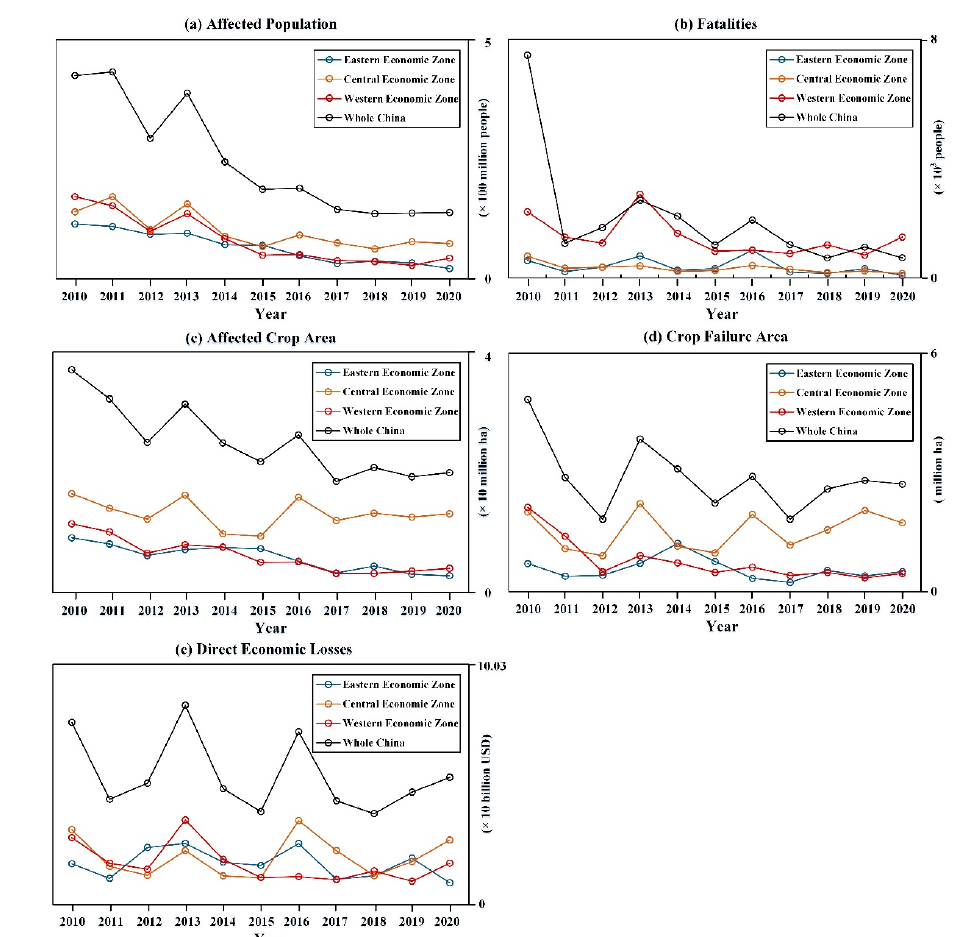
Figure 5. Trends in ( a ) affected population, ( b ) fatalities, ( c ) affected crop area, ( d ) crop failure area, ( e ) direct economic losses caused by natural disasters, from 2010 to 2020, in China. Regarding the affected population, except for Tianjin and Shanghai (Figure 3a), the provinces all presented a decreasing trend. However, there were three cutoff points during the study period. In 2010, approximately 425.18 billion people were affected by natural disasters. The main reason is that a 7.1 magnitude earthquake struck in Yushu of Qinghai province; this event caused significant losses to China, and 2220 people died. Another big disaster was the mudslide which hit the Zhouqu County of Gansu on August 8, which killed 1434 people. Then, in 2013, due to the 7.0 magnitude earthquake in Ya’an of Sichuan, a total of 196 people were killed, 21 people went missing and 11,470 people were injured. In 2016, a huge flood happened in Beijing, Tianjin, Shanxi, Shandong and Henan because of the heavy rainfall between the 18th and the 23rd of July. That event caused 325 fatalities. It can be seen that the people affected by natural disasters in each of the three economic zones and the whole of China showed a decreasing trend. In most situations, the Central Economic Zone had the largest number of disaster-affected people in each year, followed by the Western Economic Zone, and the Eastern Economic Zone had the least number of disaster-affected people (Figure 5a). Only the fatalities in Shanxi increased over time; the fatalities in the remaining districts all decreased (Figure 3b). Most deaths were in 2010 because of the two catastrophic disasters mentioned above. The decreasing trend was greater in the Western Economic Zone than the Eastern Economic Zone and Central